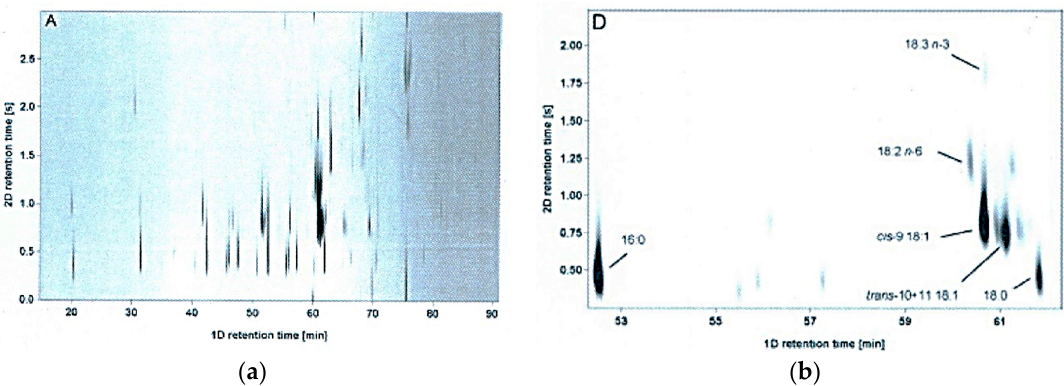
Figure 2. Comprehensive two-dimensional GC (GC × GC) chromatogram of the FAME from milk fat ( a ) and close-up of the 16–18-region ( b ) separated on a nonpolar/polar column set (BPX56BP20) (Reproduced by permission from John Wiley and Sons [86]).